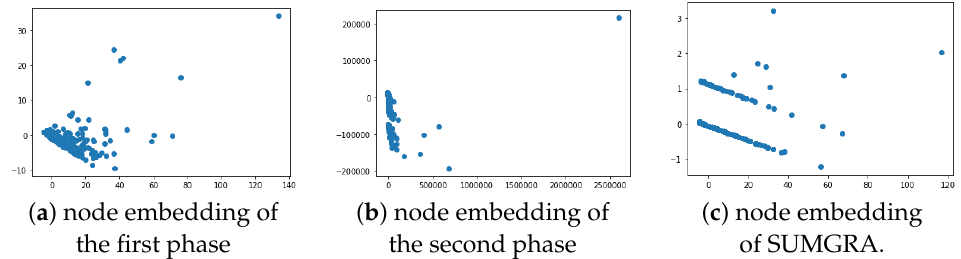
Figure 16. Node embedding of plasmodium dataset: ( a ) node embedding of the first phase of the proposed, ( b ) node embedding of the second phase of the proposed with/without meta-features, and ( c ) node embedding of the SUMGRA.